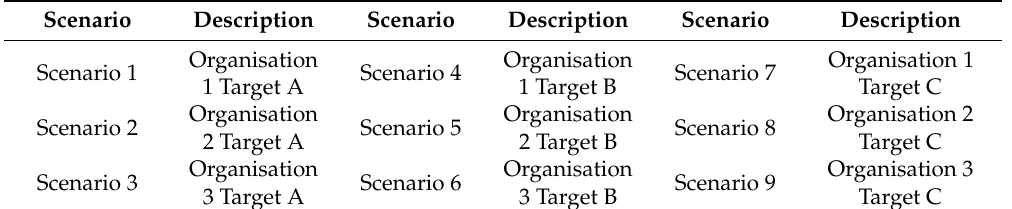
( b ) Estimated probabilities of ‘‘E. Target attraction” under different locations.